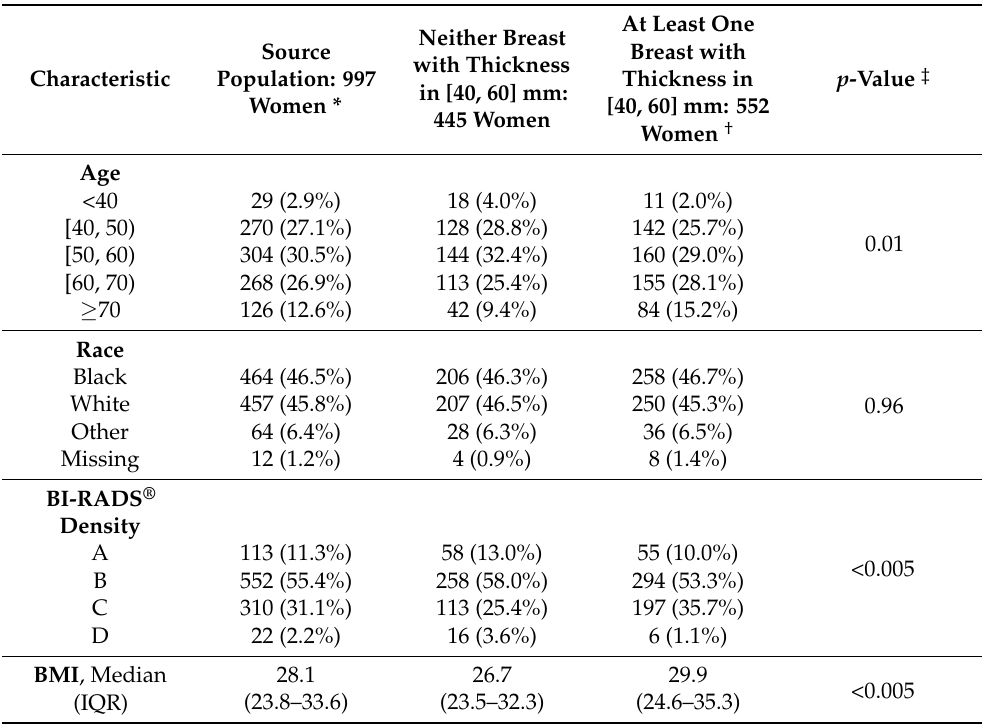
Table 1. Characteristics of participants used to calculate radiomic feature robustness metrics; both the source population and the subpopulation used for calculation of robustness metrics, with compressed breast thickness in [40, 60] mm.